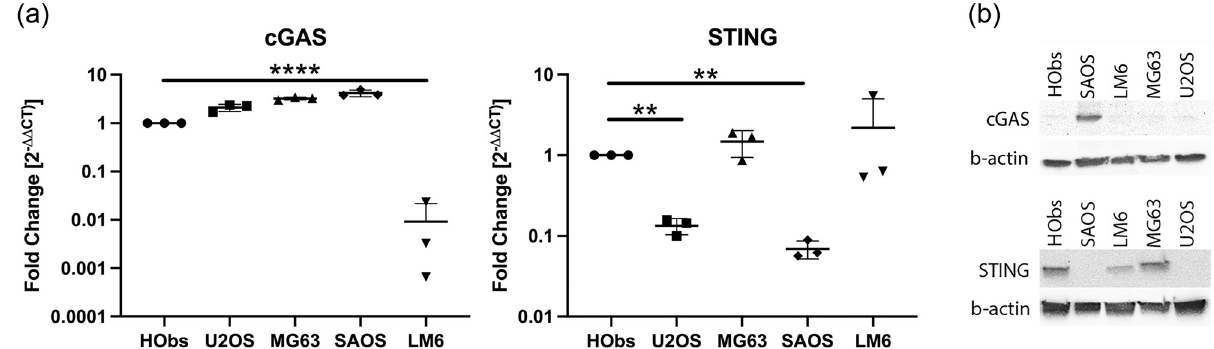
Fig 1. Expression of cGAS and STING by hOSA cell lines relative to hObs. A) cGAS and STING mRNA expression depicted as fold change (2 - ΔΔ Ct ) in hOSA cell lines relative to hObs. Log 2 (fold change) was compared between hOSA cell lines and hOBs, and comparisons yielding p values < 0.05 are shown. RT-qPCR was performed in duplicate. N = 3. The y-axes are represented on a log 10 scale. B) cGAS and STING protein expression in hObs and hOSA cell lines was determined Western blot. A representative image is shown, depicting cGAS expression (~62 kDa), STING expression (~35 kDa) and the loading control, β -actin (~45 kDa). Individual data points are plotted, mean and SD are shown. Three independent replicates were performed. ** p < 0.01; **** p < 0.0001.